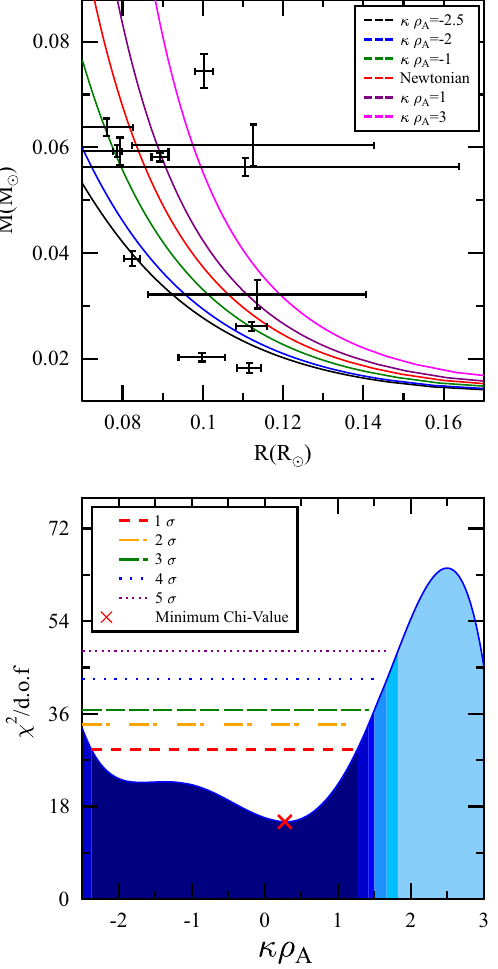
Fig. 2 The upper and lower panels show the mass-radius relation of the BD calculations for the current epoch based on EiBI theory with a variety of κρ A values and the corresponding chi-square per d.o.f vs γ relation. The corresponding observation data of [1] with the associated error bars are also given. Here, d . o . f = 22. The shaded area with the blue region contours shows 1 to 5 σ confidence levels. ρ A = ρ (cid:2) × 10